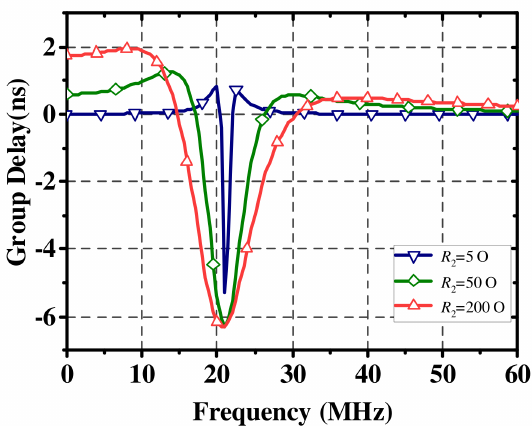
Figure 4. Band-pass negative group delay with different R 2